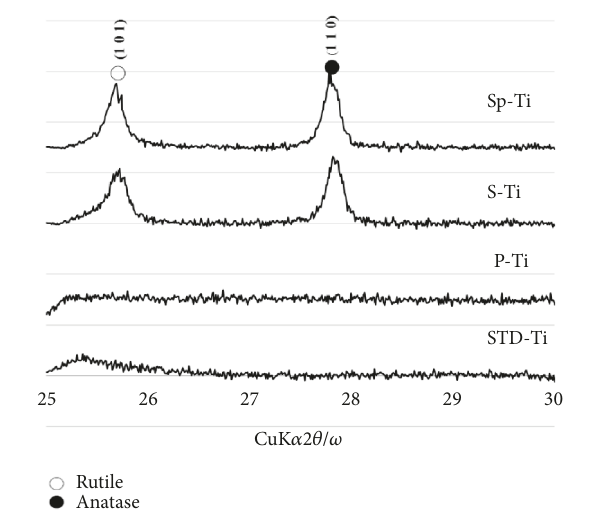
Figure 7: XRD patterns of Ti plate samples.